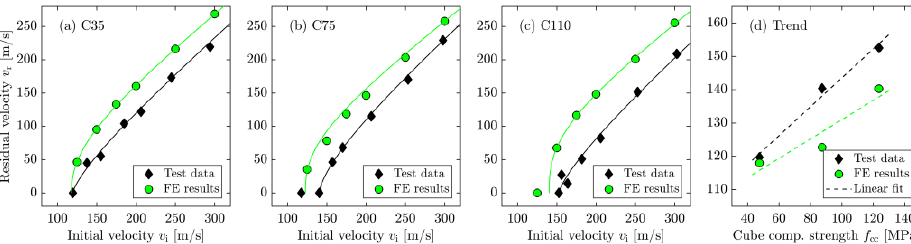
Fig. 4. Experimentally and numerically obtained ballistic limit curves for (a) C35, (b) C75 and (c) C110 concretes, and (d) ballistic limit as function of cube compressive